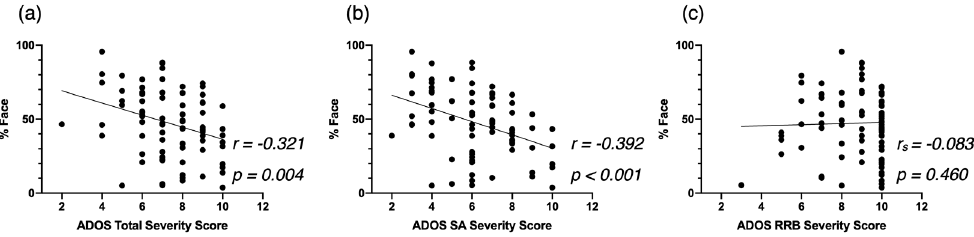
Figure A4. Correlation between %Face and the ADOS-2 Total Severity Score ( a ), the ADOS-2 SA Severity Score ( b ), and the ADOS-2 RRB Severity Score ( c ), at baseline for the male-only cross-sec- ADOS-2 RRB Severity Score ( c ), at baseline for the male-only cross-sectional ASD tional ASD group.